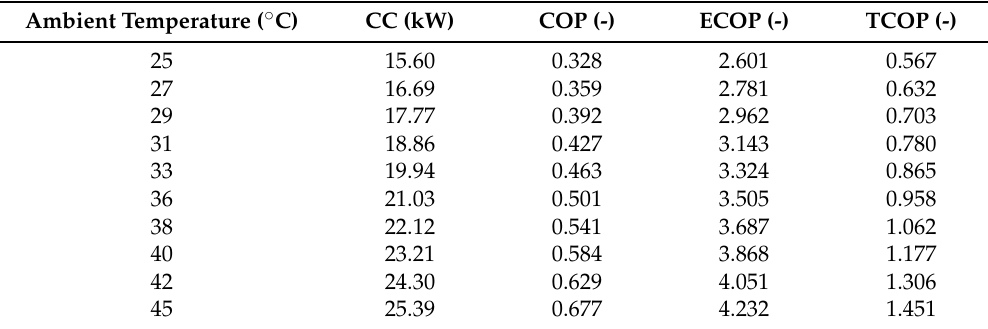
Table 5. Effect of ambient temperature on the system performance.